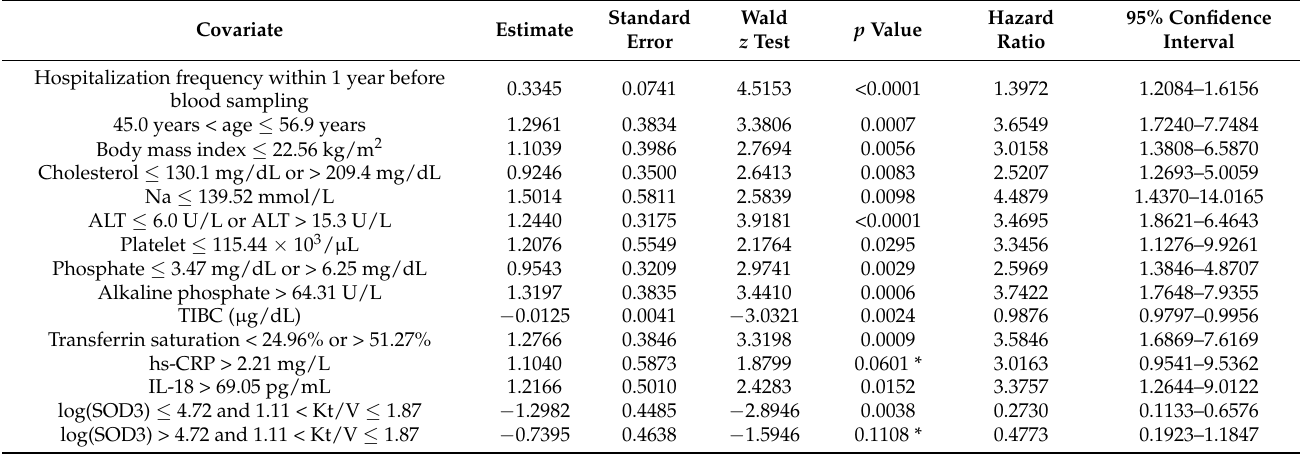
Table 2. Multivariate analysis of the predictors of time to the first kidney disease-related hospitaliza- tion or death using a Cox proportional hazards model in ESRD patients on regular